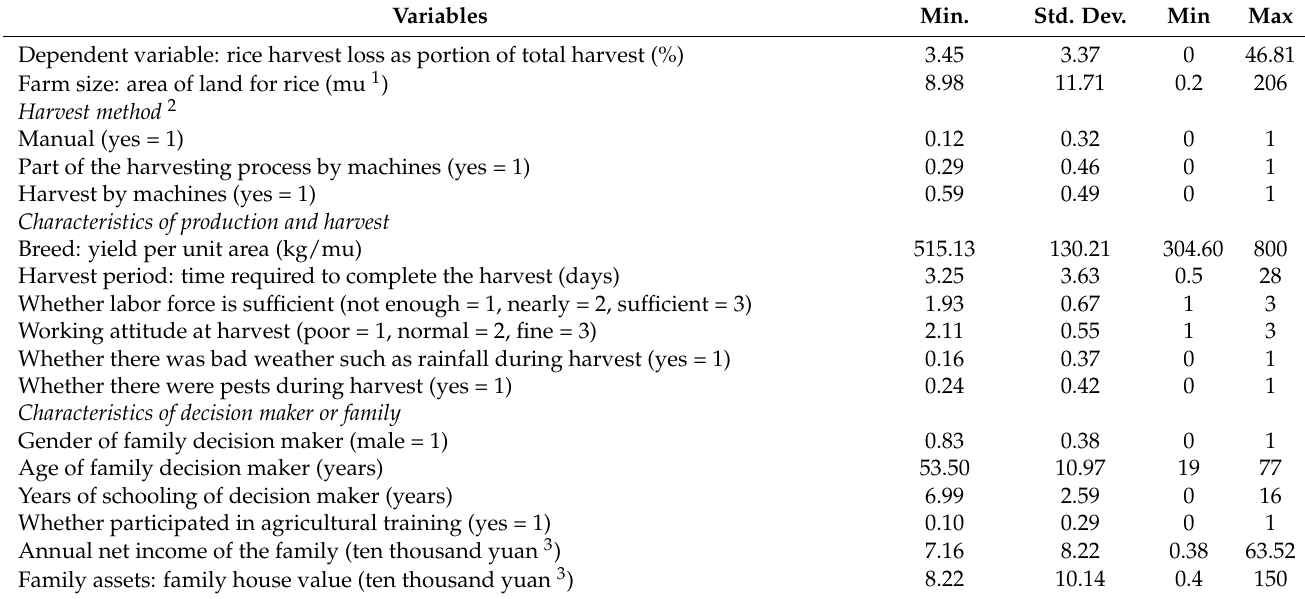
Table 4. Variable definitions and descriptive